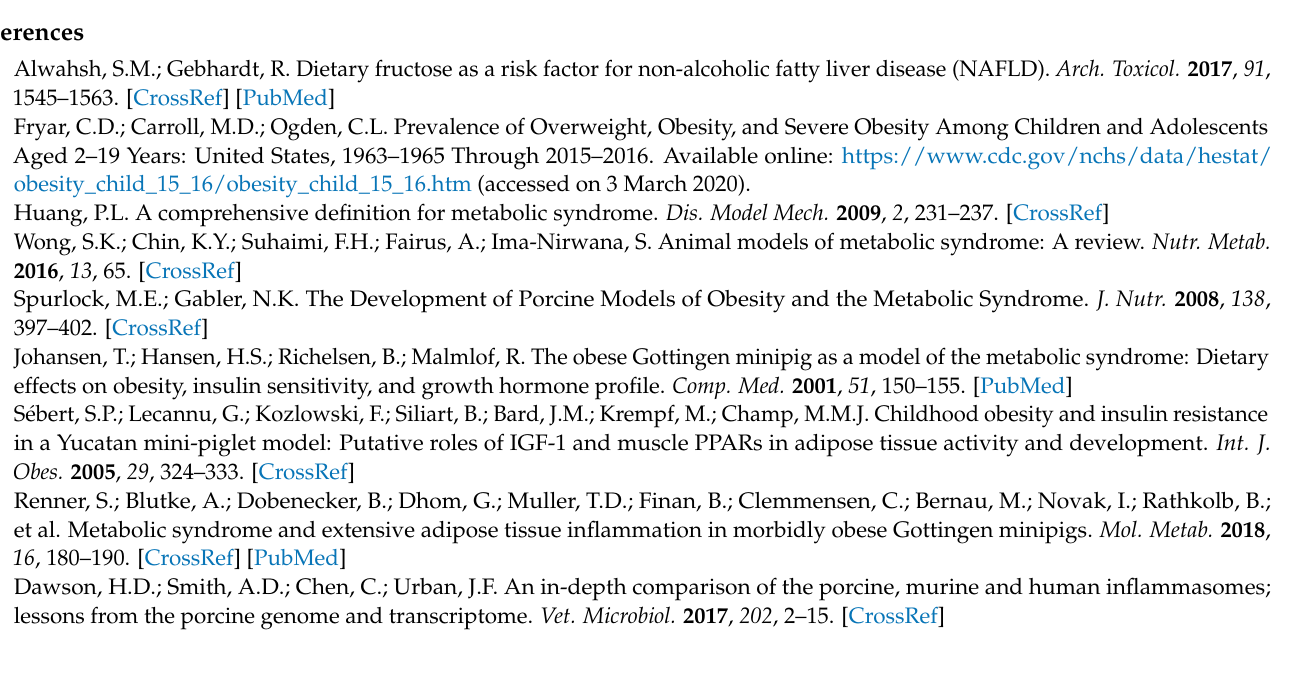
Plasma concentrations (ng/mL) of inflammation biomarkers after overnight fasting; Figure S1. Flow chart presentation of experimental procedures, samples collected, and analysis performed in this longitudinal dietary trial; Figure S2. Photos of the liver biopsy procedure; Figure S3. Morphometric measurements of Göttingen Minipigs fed ad libitum a high-risk (HR, n = 15) and a lower-risk (LR, n = 15) diet; Figure S4. Spearman correlations between the body weight and albumin levels in the plasma of Göttingen minipigs fed a high-risk (left panel) and a low-risk (right panel)